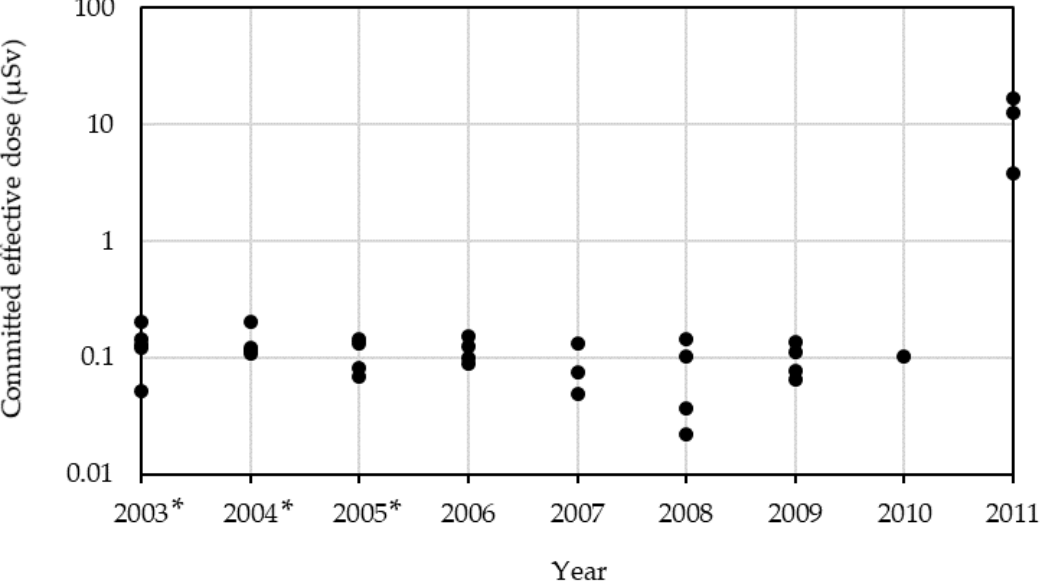
Figure 2. Committed e ff ective doses of radioactive Cs ( 137 Cs + 134 Cs) obtained from each market basket (2003–2011). The closed circles show the results of each market basket. The doses were estimated with the assumptions of one-year intake values of the total diet samples, and the activity concentration values of non-detected radionuclides to be